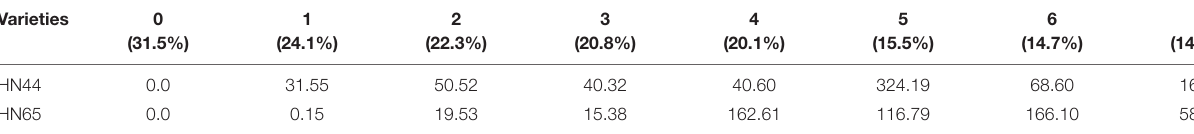
TABLE 3 | Effect of drought on the relative growth rate of proline content (%). Varieties